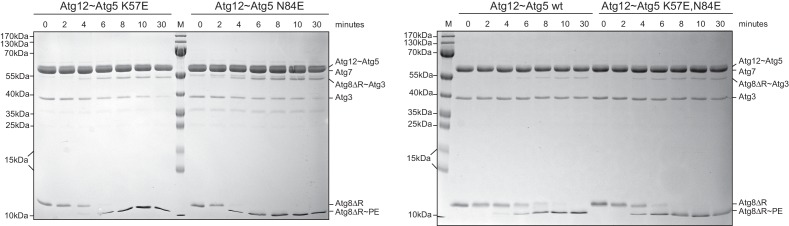
The K57E and N84E mutations do not impair the ability of the Atg12~Atg5 conjugate to promote Atg8 conjugation.In vitro Atg8 lipidation reaction using SUVs and wild type as well the indicated Atg12~Atg5 mutants. Shown are Coomassie stained gels of a time series of Atg8 conjugation reactions in the presence of Atg12~Atg5 K57E or N84E (left panel) and wild type or K57E,N84E mutant (right panel). The Atg12~Atg5 band is not visible on the gel at the concentrations used in this experiment. The Atg8~PE is detected as a faster migrating band in a urea containing gel.